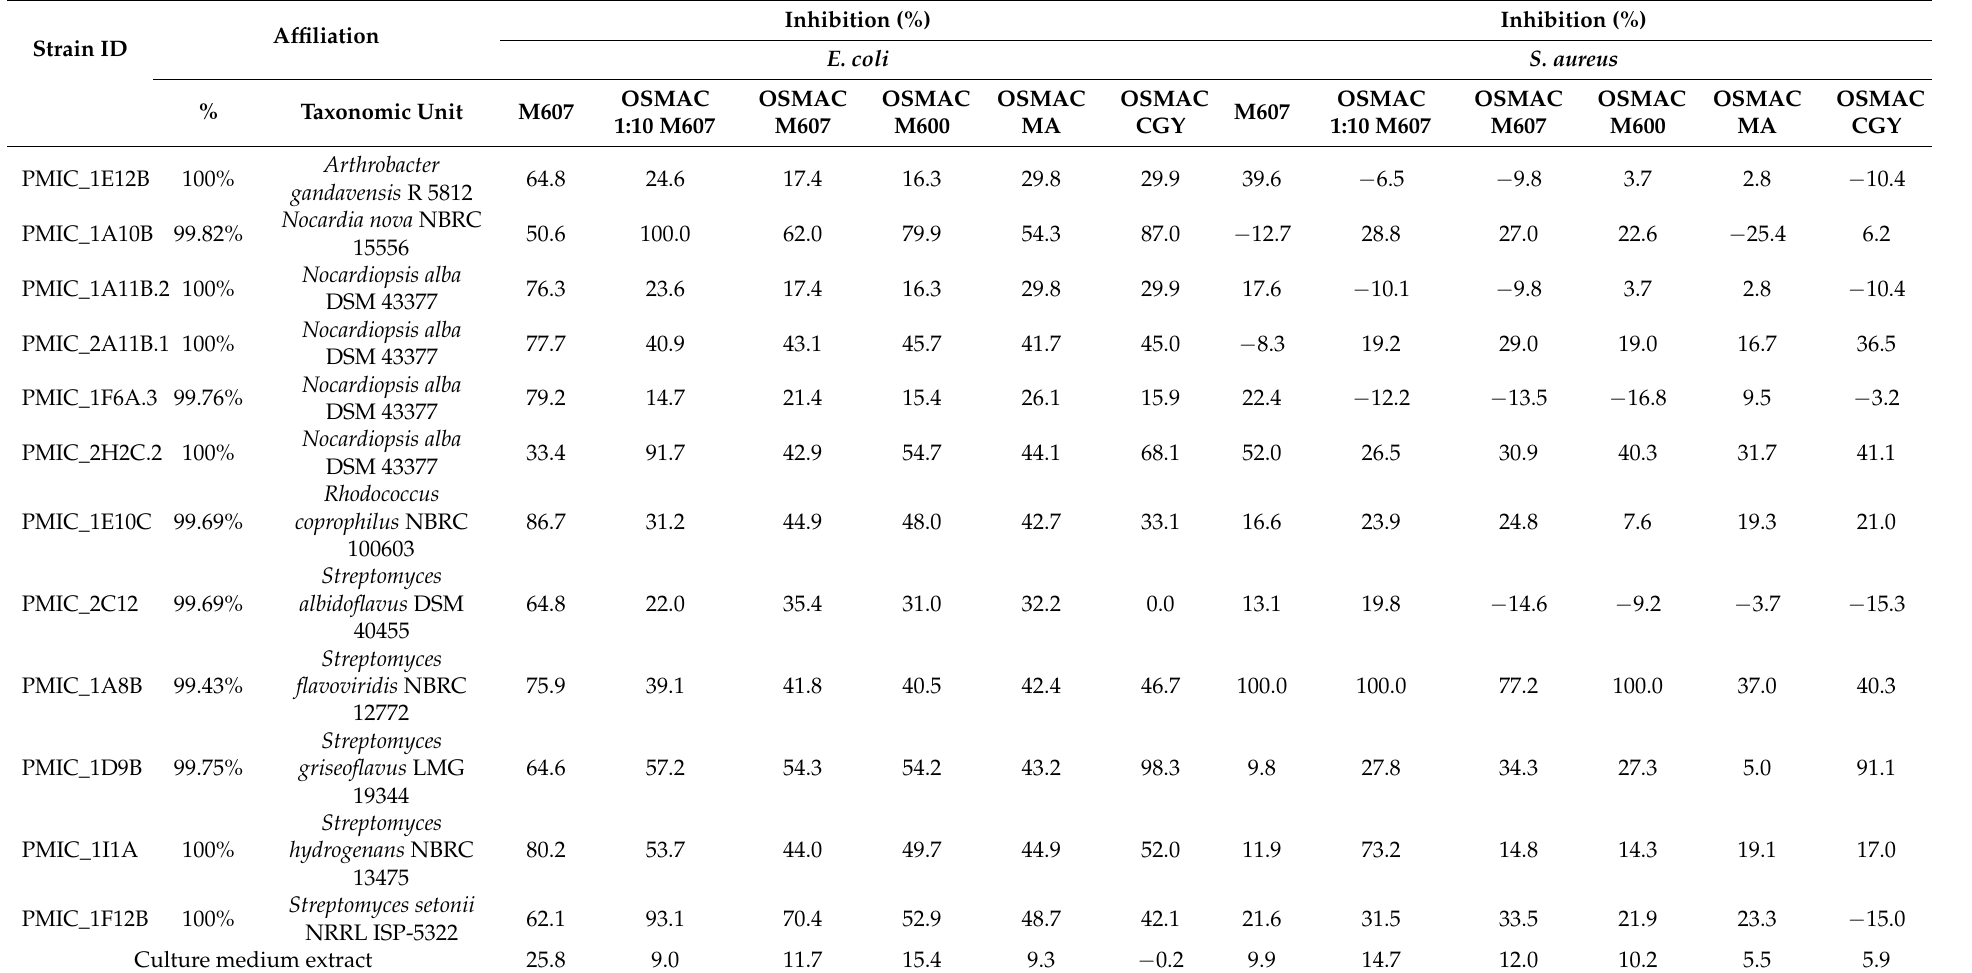
Table 2. Bioactive actinomycetotal strains’ average inhibition of the extracts produced from all